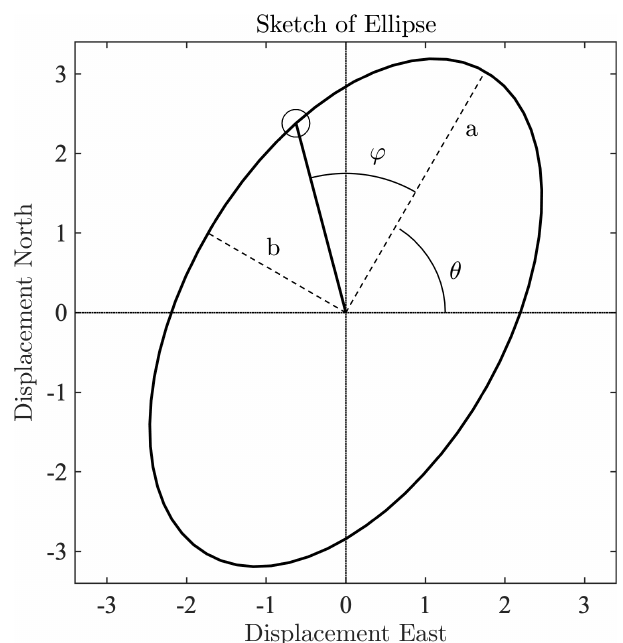
Figure 3. A schematic of a particle orbiting an ellipse, as de- scribed by Eq. (1). The semi-major axis a(t) , semi-minor axis b(t) , orientation angle θ(t) , and particle position angle ϕ(t) are all la- beled. The circle denotes the instantaneous particle position. Here a(t) = 3 . 5, b(t) = 2, and θ(t) = φ(t) = π/ 3. These values imply (cid:112) [ ϕ(t) = π/ 4 . 03 together with κ(t) ≡ a 2 (t) + b 2 (t) ] / 2 = 2 . 85 and ξ(t) ≡ 2 a(t)b(t)/ [ a 2 (t) + b 2 (t) ] = 0 . 86, with the latter two quanti- ties defined subsequently in Sect.